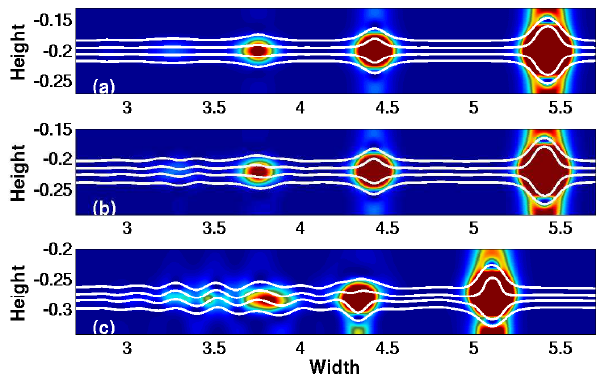
Fig. 9. Plot of the kinetic energy at t = 100s for the symmetric (a) , 5% (b) and 20% (c) shifts. The colorbar was saturated at 10% of the maximum value of the symmetric